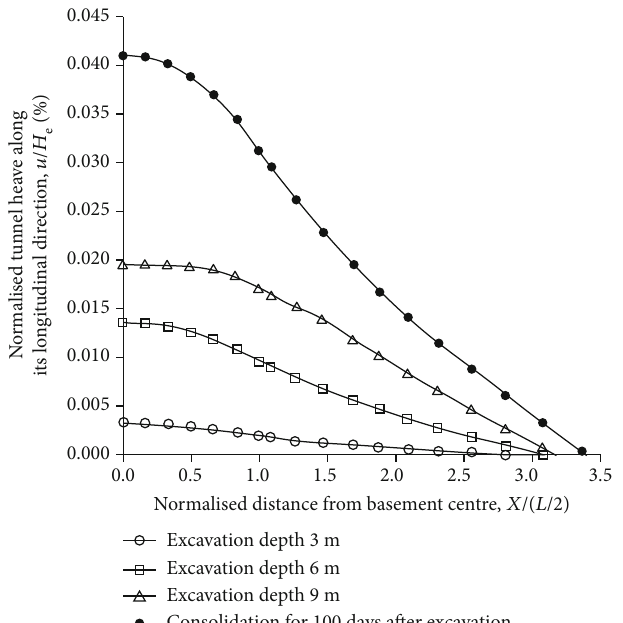
Figure 2: Normalised tunnel displacement along tunnel axis.